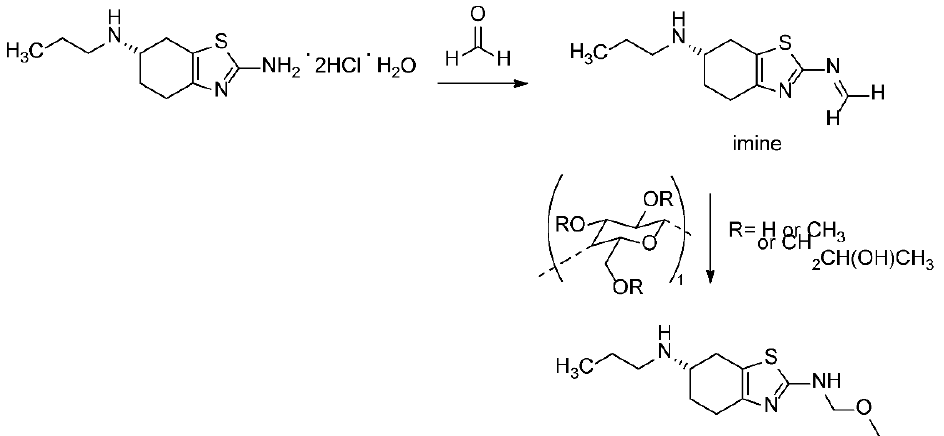
Figure 8. The proposed formation mechanism of pramipexole N-methoxymethyl degradation im- purity.